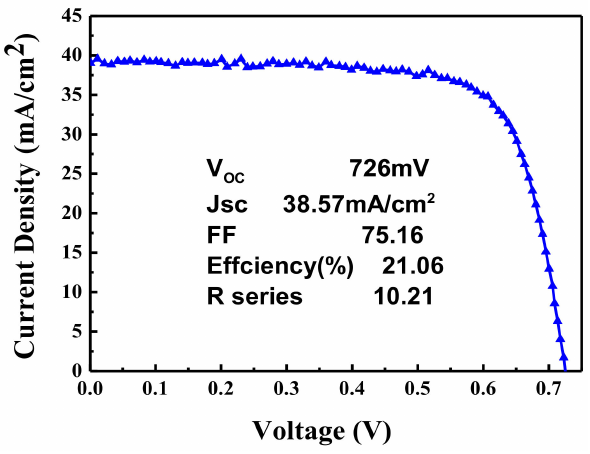
Figure 6. I–V Curve for the ALD-MoO X applied HIT cell. Reproduced with permission from Reference